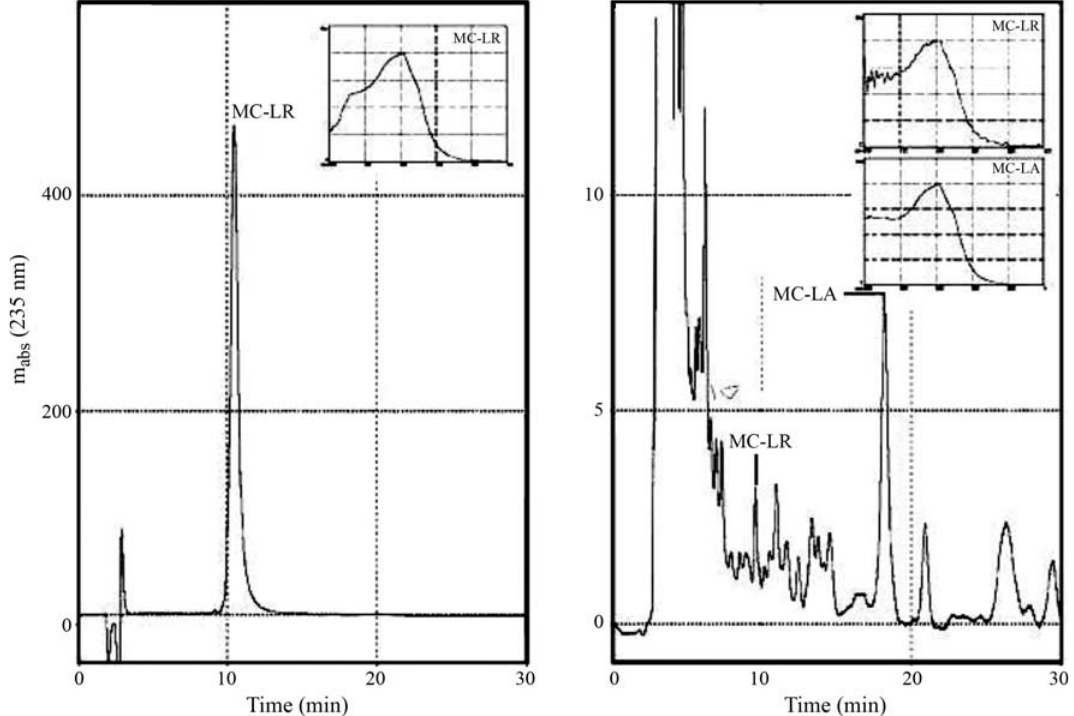
Figure 1 - Chromatogram with standard microcystin-LR (left) and the studied extract from a bloom of cyanobacteria showing the strong presence of microcystin-LR and at second concetration level microcystin-LA